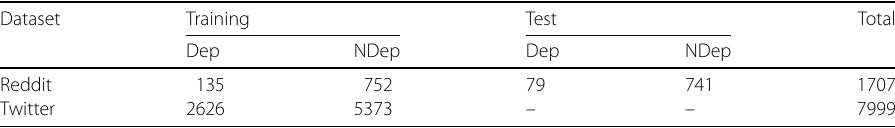
Table 1 Description of datasets. Number of depressed (Dep) and non-depressed (NDep) users in the train and test